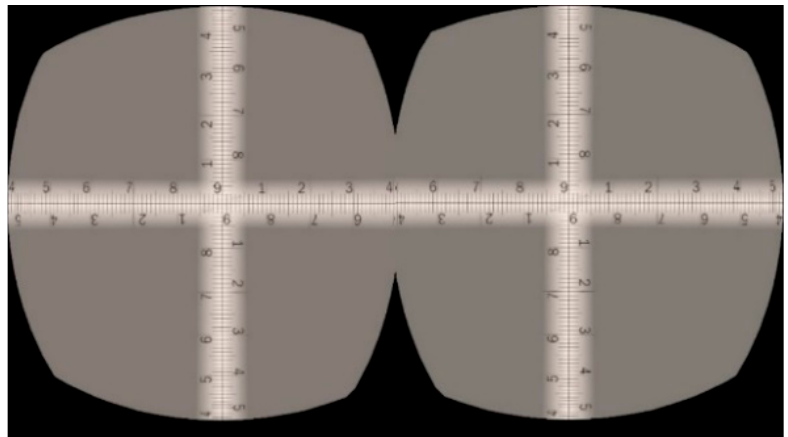
Figure 4. Rendering HFOV of VR HMD (Oculus Quest).